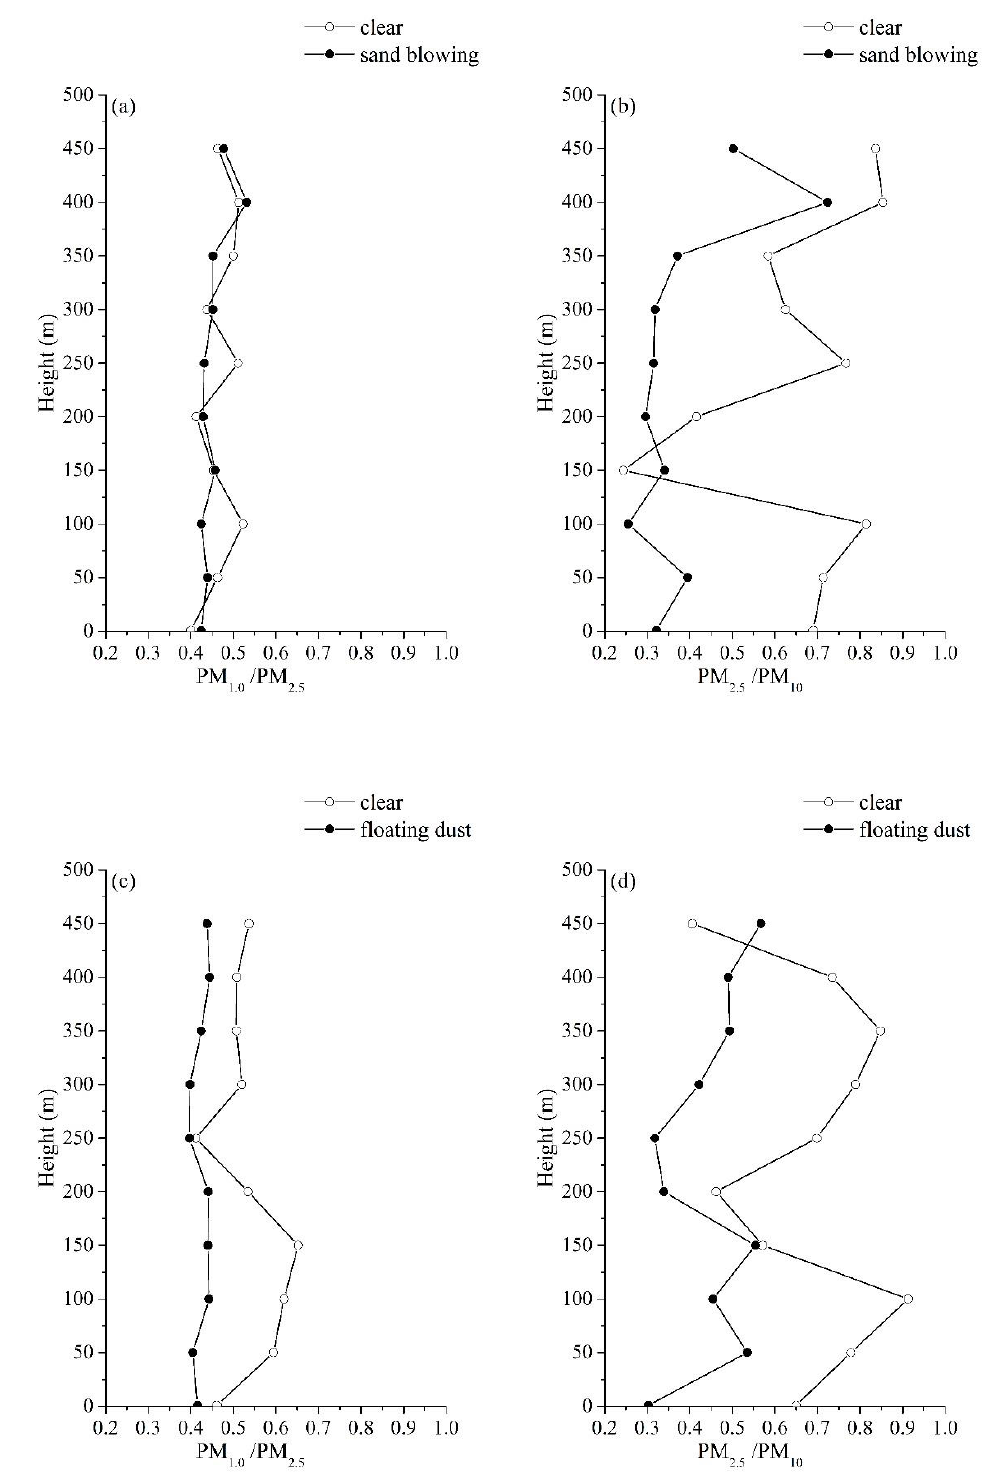
Figure 14. Ratios of PM 1.0 / PM 2.5 and PM 2.5 / PM 10 during the clear period (12:00 local time, 8 November) and a sand blowing period (18:00 local time, 11 November) at Tazhong ( a , b ) and during a clear period (18:00 local time, 14 November) and a floating dust period (15:00 local time, 13 November) at Xiaotang ( c , d ).